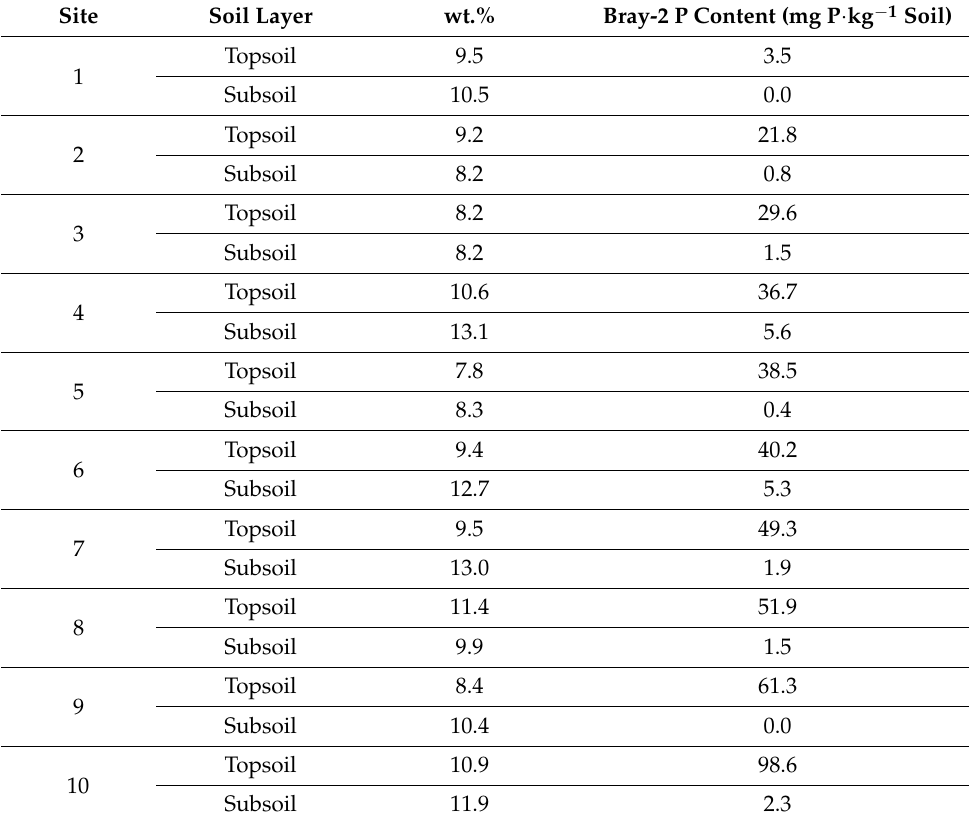
Table 1. Bray-2 P levels of red sandy soils at Vaalharts irrigation scheme (extracted from Eloff and Laker [13]). Site Soil Layer wt.% Bray-2 P Content (mg P · kg − 1 Soil)